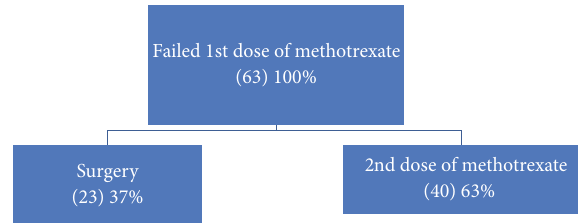
Figure 2: Modalities of treatment after failure methotrexate.